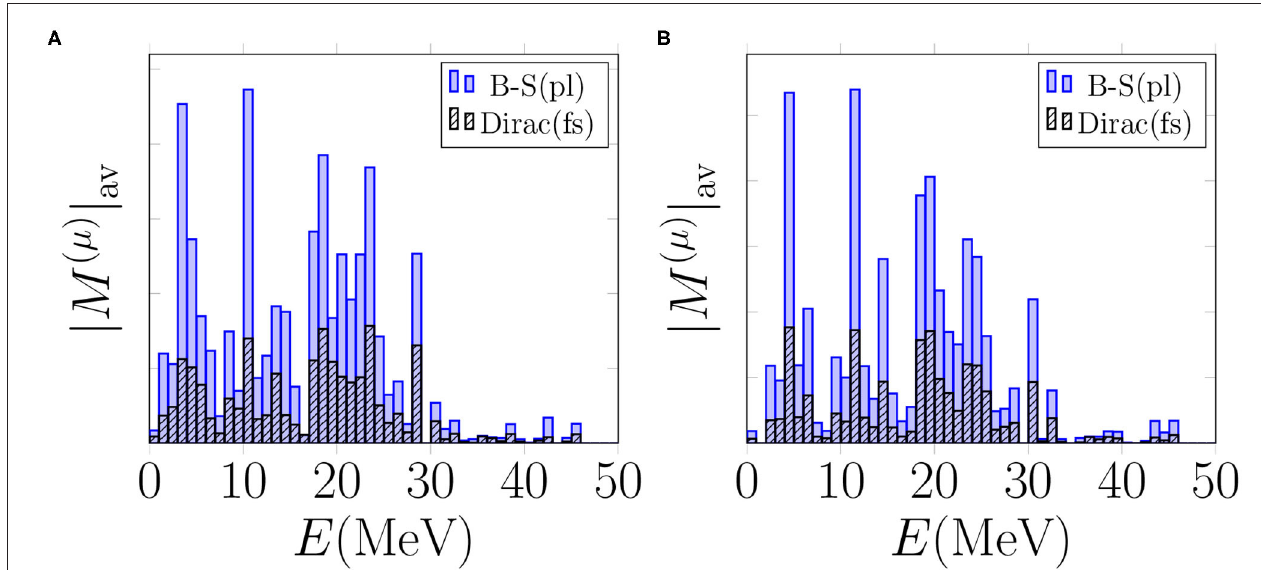
FIGURE 9 | Average OMC matrix elements for the captures to J π = 1 + states computed with different bound-muon wave functions. “B-S(pl)” denotes the Bethe-Salpeter point-like-nucleus approximation and “Dirac(fs)” the exact wave function solved from the Dirac equation taking into account the finite size of the nucleus. The value g ( T = 0) pp = 0.7 is adopted for particle-particle interaction parameter. (A) Basis: “Adj.”. (B) Basis: “WS”.